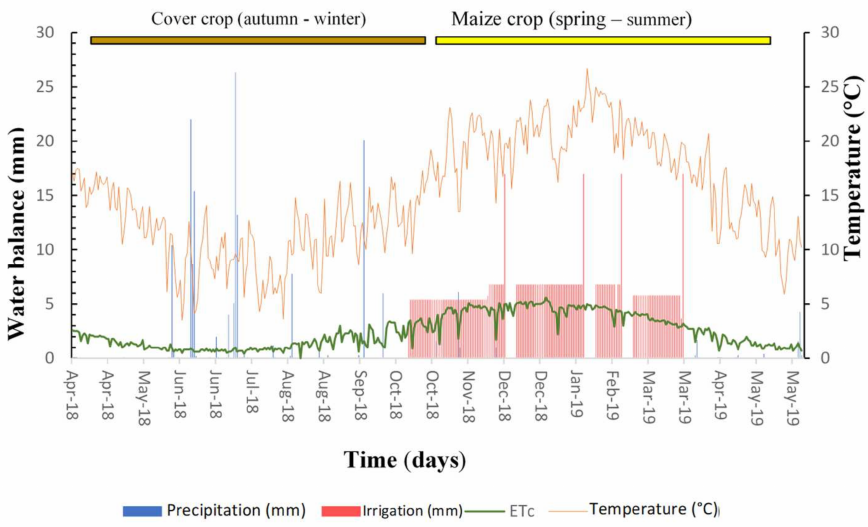
Figure 1. Daily mean of the precipitation, crop evapotranspiration (ETc), irrigation, and air tempera- ture registered during the crop rotation (maize–cover crop) between April 2018 and May